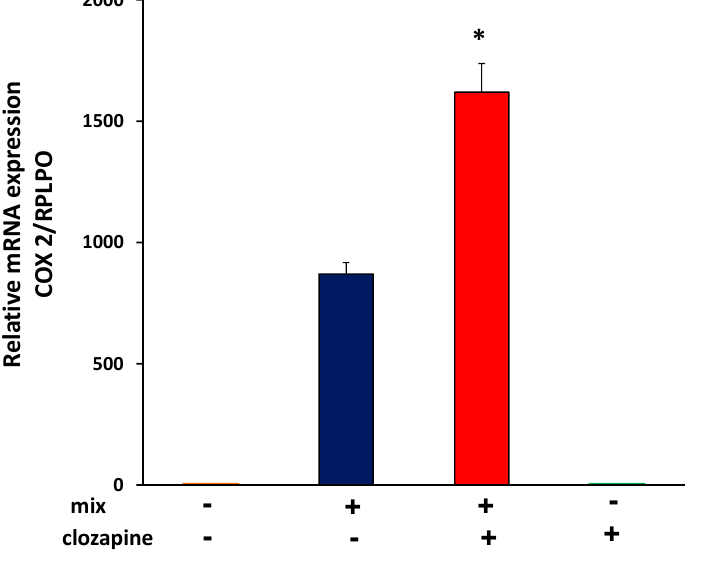
Figure 3. Effects of clozapine on COX2 gene expression. A172 cells were treated with clozapine (10 µM) 45 min prior to the addition of cytokine mix, left for a duration of 24 h. COX2 mRNA levels were determined by RT-PCR ( p < 0.01, n = 4 in each group). Data are expressed as Mean ± SEM and represents one of 5 similar experiments. Details on all 5 experiments are presented in the text. * p < 0.01 vs. mix.